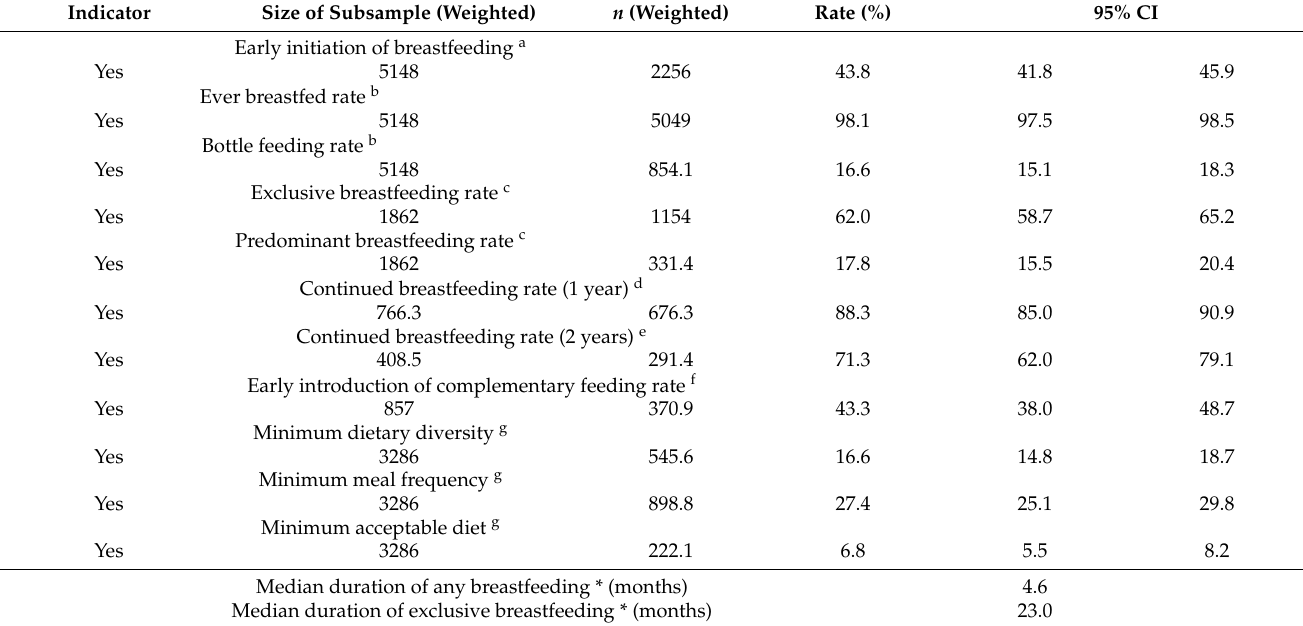
Table 2. Breastfeeding indicators among children 0–23 months of age, India.